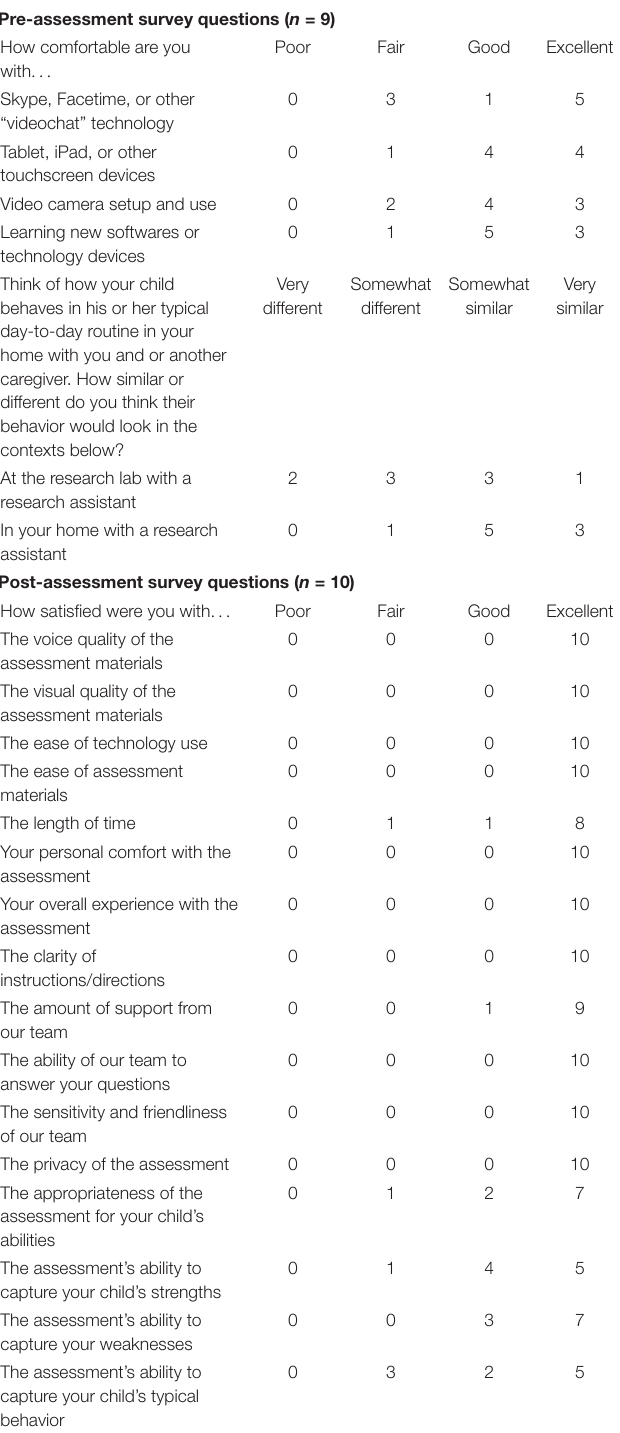
TABLE 2 | Pre- and post-assessment